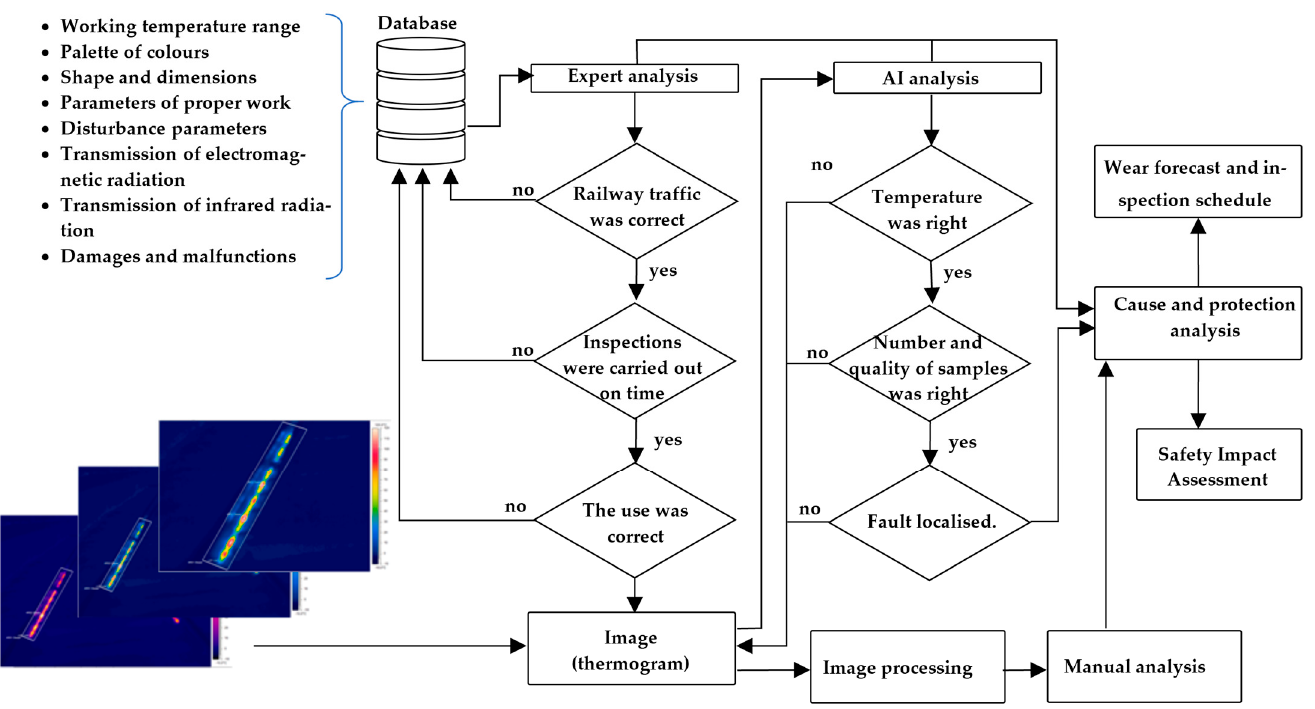
Figure 18. Algorithm of the method.